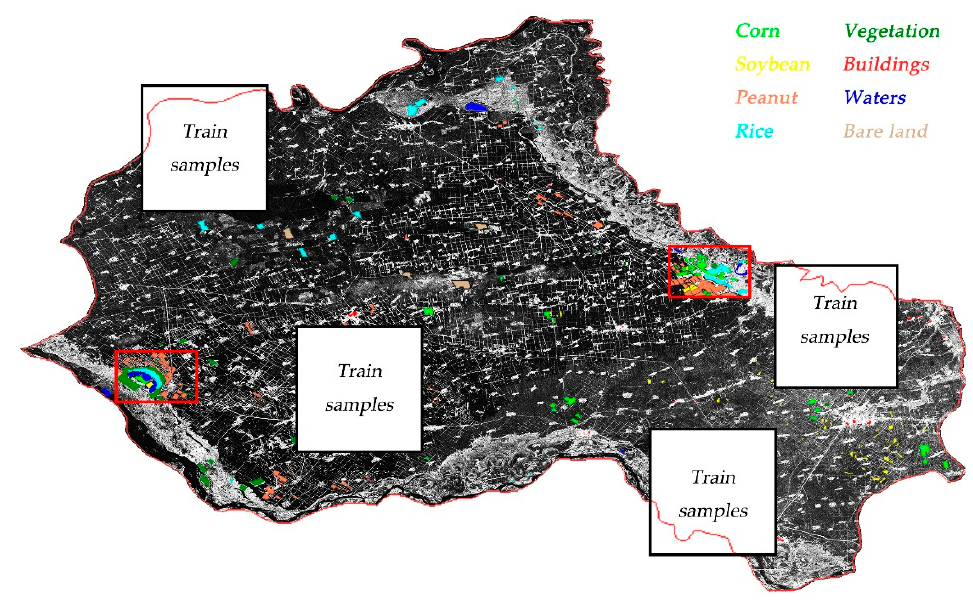
Figure 4. The ground truth of study area. Colored polygons represent the reference plots location